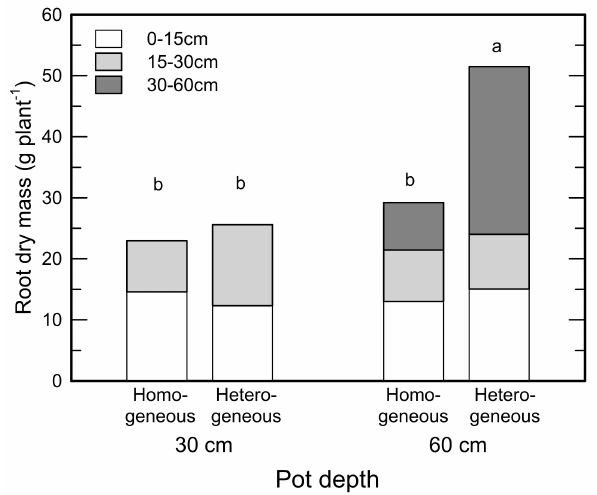
Figure 4. Root dry mass of Populus sibirica seedlings in 30 and 60 cm containers and in homogenous and heterogeneous substrates. Different lowercase letters indicate significant differences between substrate heterogeneity treatments × container depth